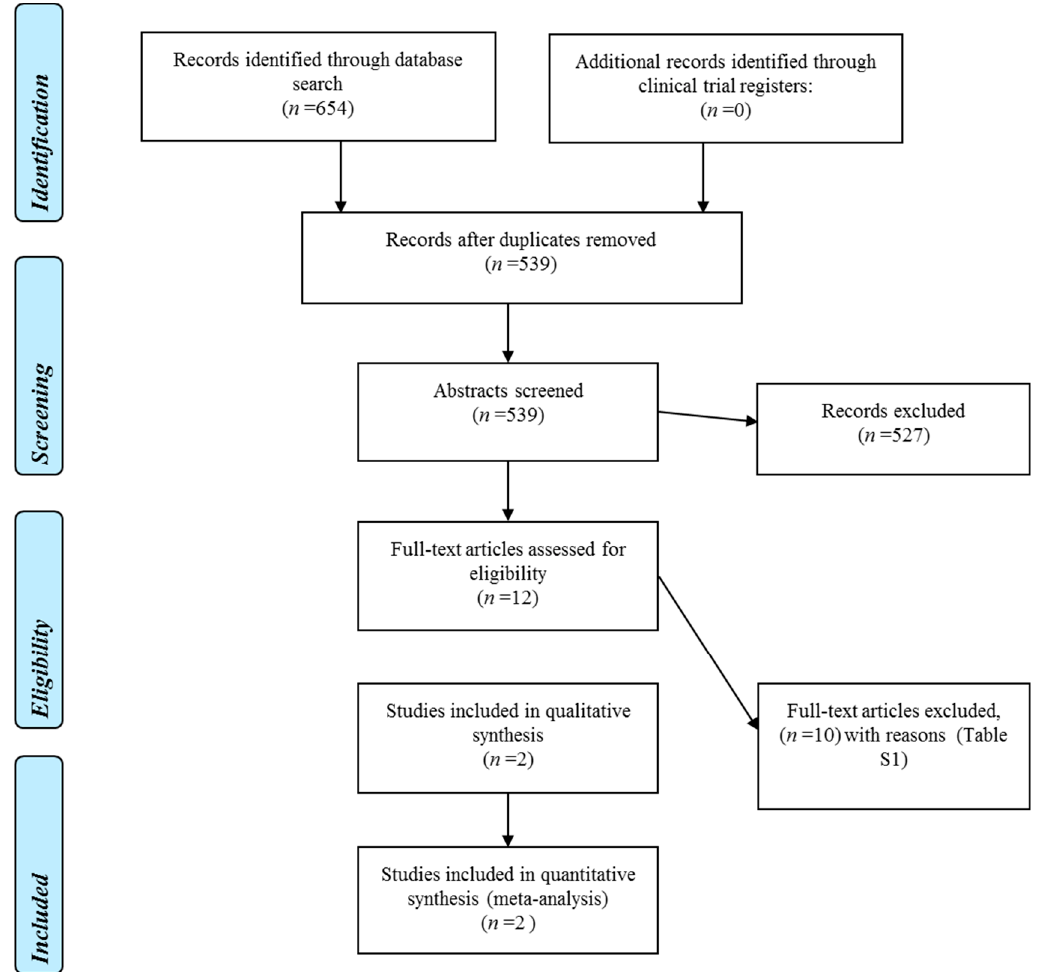
Figure 1. PRISMA diagram for study selection process for systematic review and meta-analysis.